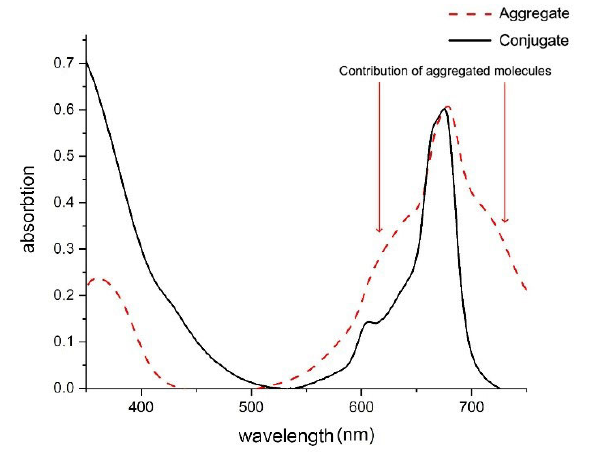
Figure 4. Comparison of the absorption spectra of the conjugate 1 and the aggregate. The samples were dissolved in distilled water. The molar concentration of QDs in the conjugate was 33 µ M. The molar concentration of AlPc in conjugate 1 was 20.4 μ M.